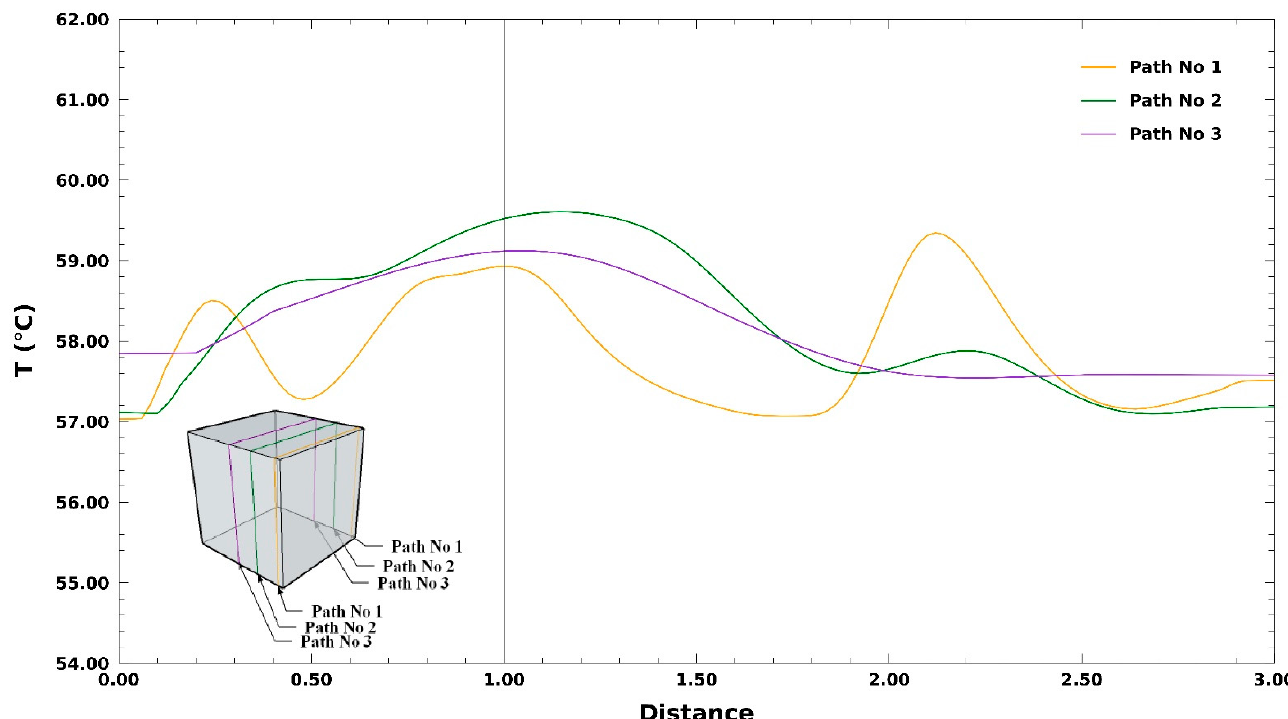
Figure 12. Temperature distribution on the vertical and horizontal surfaces of the building for the Scenario C along three different streamwise paths.